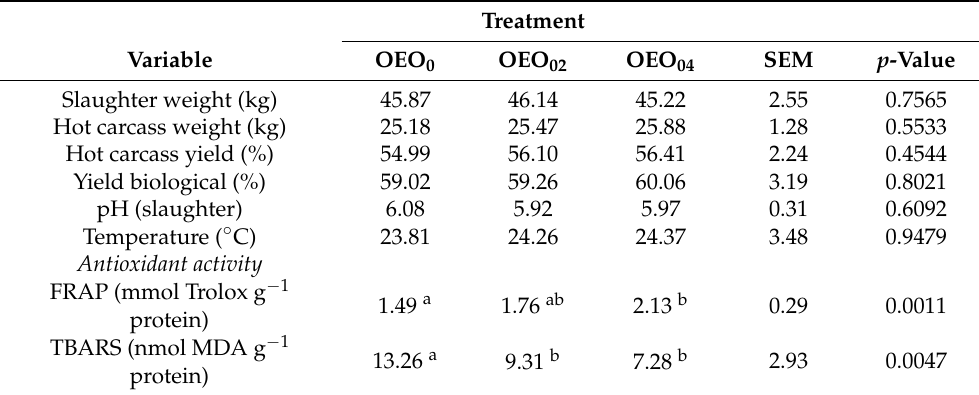
Table 4. Carcass characteristics and antioxidant activity in meat from lambs fed with different oregano essential oil levels in the